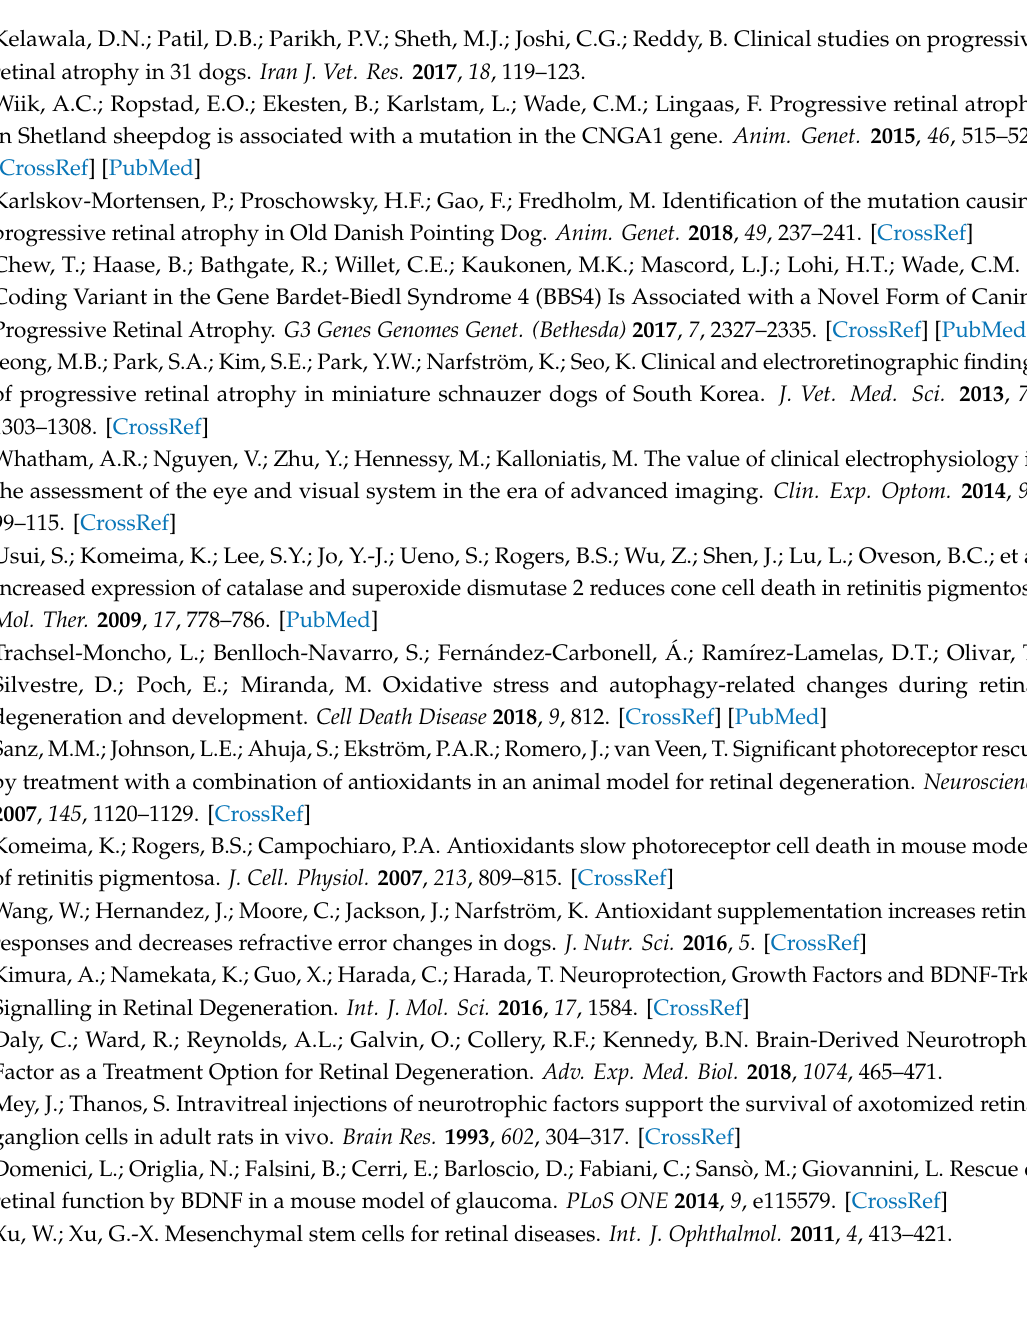
Table S1: Sequences and description of primers used for